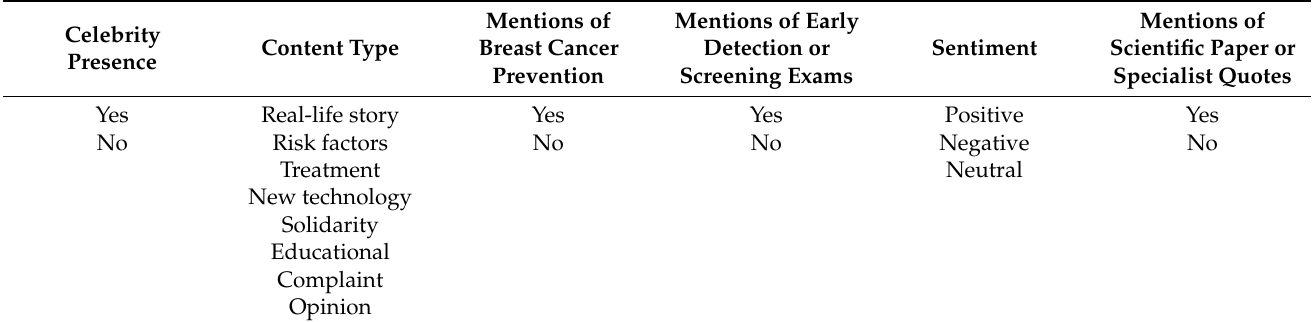
Table 1. Coding manual, including the coding schedule and its